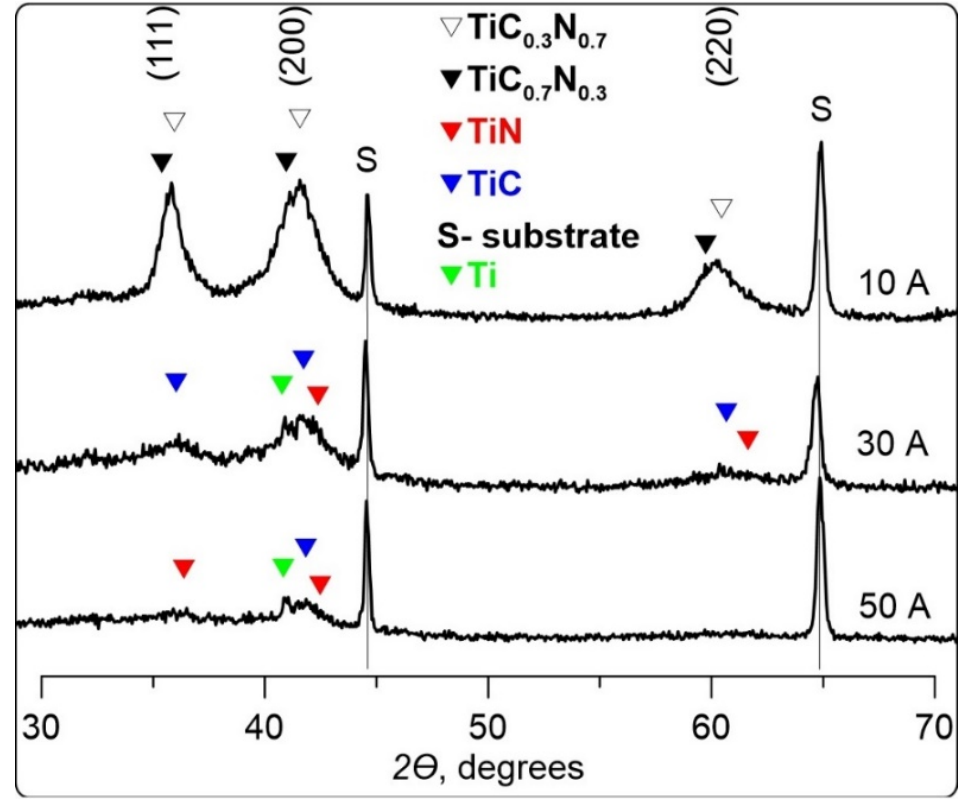
Figure 7. XRD patterns of TiSiCN coatings.